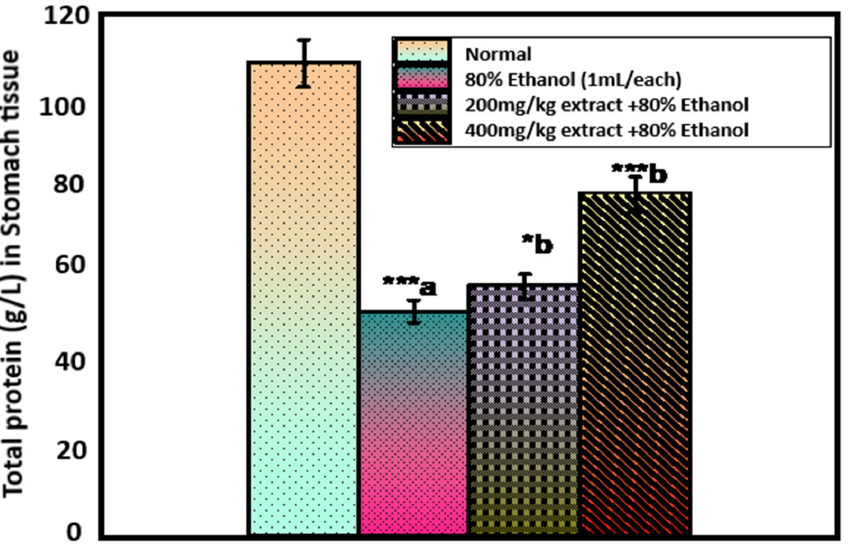
Figure 4. Effect of O. forsskalii extracts on the total phenol concentration in gastric ulcer induced by 80% ethanol. Six rats were used in each group. p values (* p < 0.05, *** p < 0.001). Where, a: 80% ethanol treated group was statistically compared to the normal group; b: O. forsskalii treated groups were compared to the ethanol-treated group.